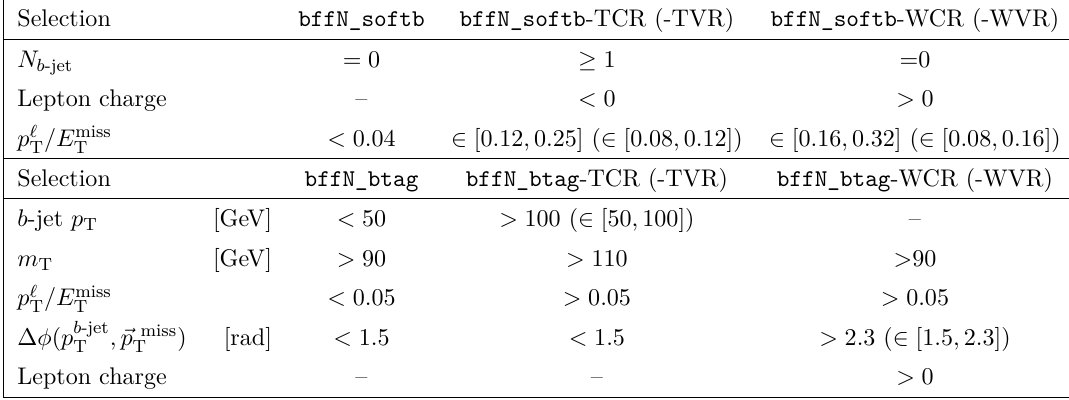
Table 12. Event selections defining the CRs and VRs in bffN_softb and bffN_btag relative to their respective signal